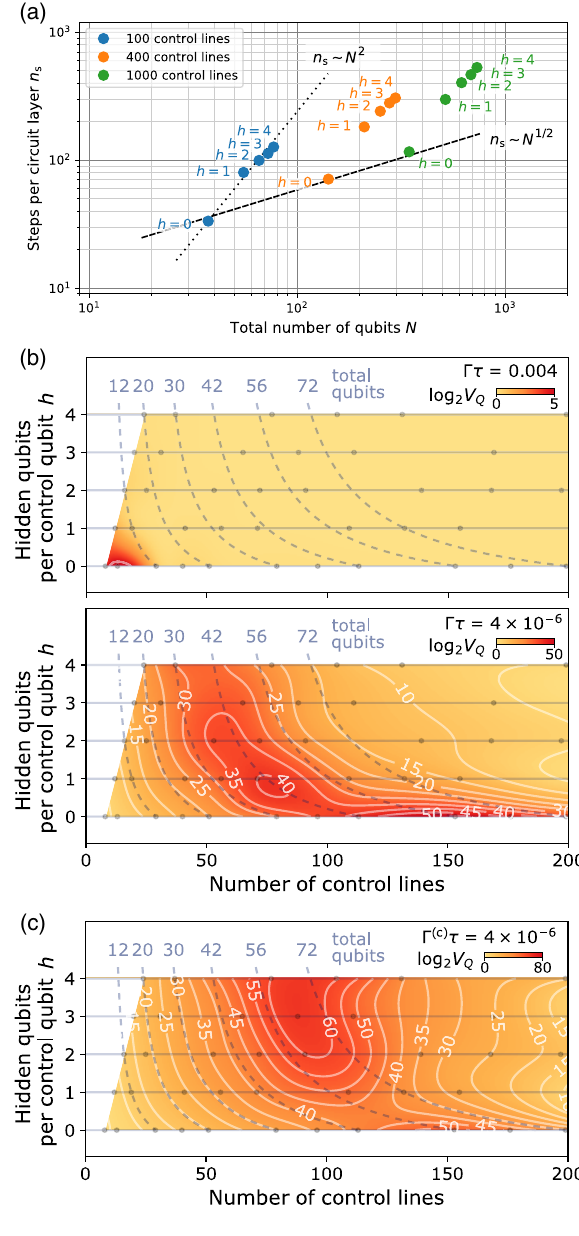
FIG. 2. (a) Number of time steps per single circuit layer as a function of the number of qubits for h ¼ 0 to h ¼ 4 hidden qubits and a constant number of control lines (100, 400, and 1000). (b) Estimated quantum volume as a function of the number of control lines for different numbers h of hidden qubits per control qubit. The gray dots mark the set of grids for which the quantum volume was calculated. The value indicated by the density plot and the contours was obtained by interpolation from these. The curved dashed lines indicate constant total numbers of qubits. In (b), we assume all qubits are subject to the same error probability per two-qubit gate duration Γ τ and compare two different values of this parameter (0.004 and 4 × 10 − 6 ). In (c), we assume only control qubits undergo significant decoherence with a probability Γ ð c Þ τ ¼ 4 × 10 − 6 per two-qubit gate